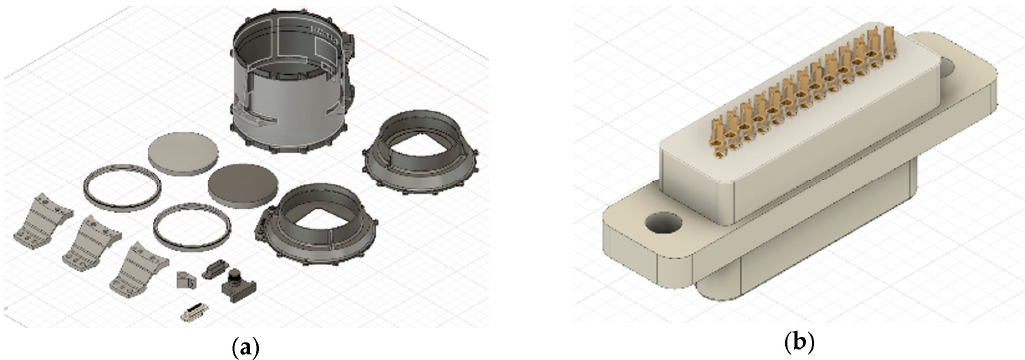
Figure 8. ( a ) Connector of Subassembly 8 in relation to the rest of its pieces. ( b ) Detail view of the connector.